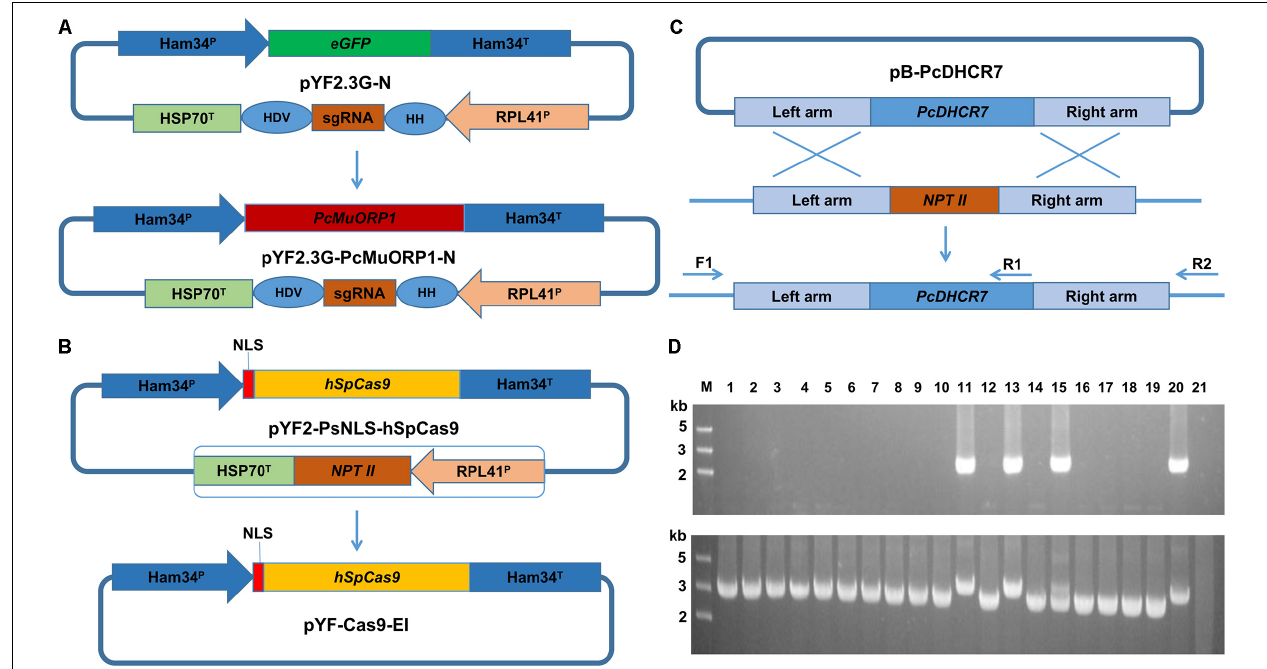
FIGURE 1 | Plasmid modification and complementation of the PcDHCR7 gene. (A) Replacement of the eGFP gene in pYF2.3G-N by the fungicide resistance gene PcMuORP1 to generate the novel plasmid pYF2.3G-PcMuORP1-N. HH, hammerhead (HH) ribozyme; HDV, HDV ribozyme. (B) Removal of the NPT II expression cassette from pYF2-PsNLS-hSpCas9 to form pYF-Cas9-EI. (C) Schematic representation of the homologous recombination that restored the PcDHCR7 gene in place of the NPT II gene in P. capsici isolate KD1-1, showing the location of the primers used to validate complementation had occurred and to